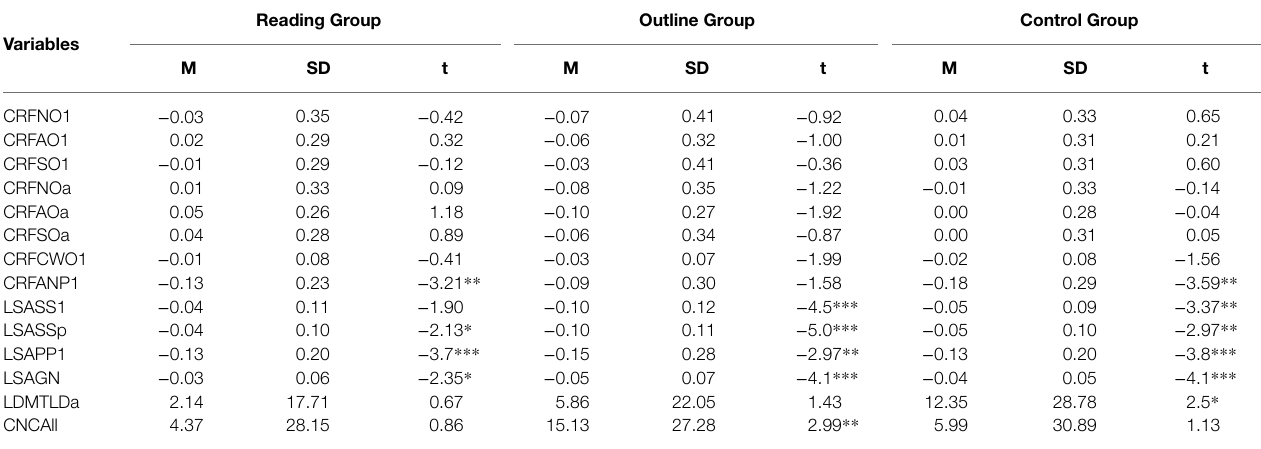
TABLE 3 | Results of paired t-test for cohesion scores.